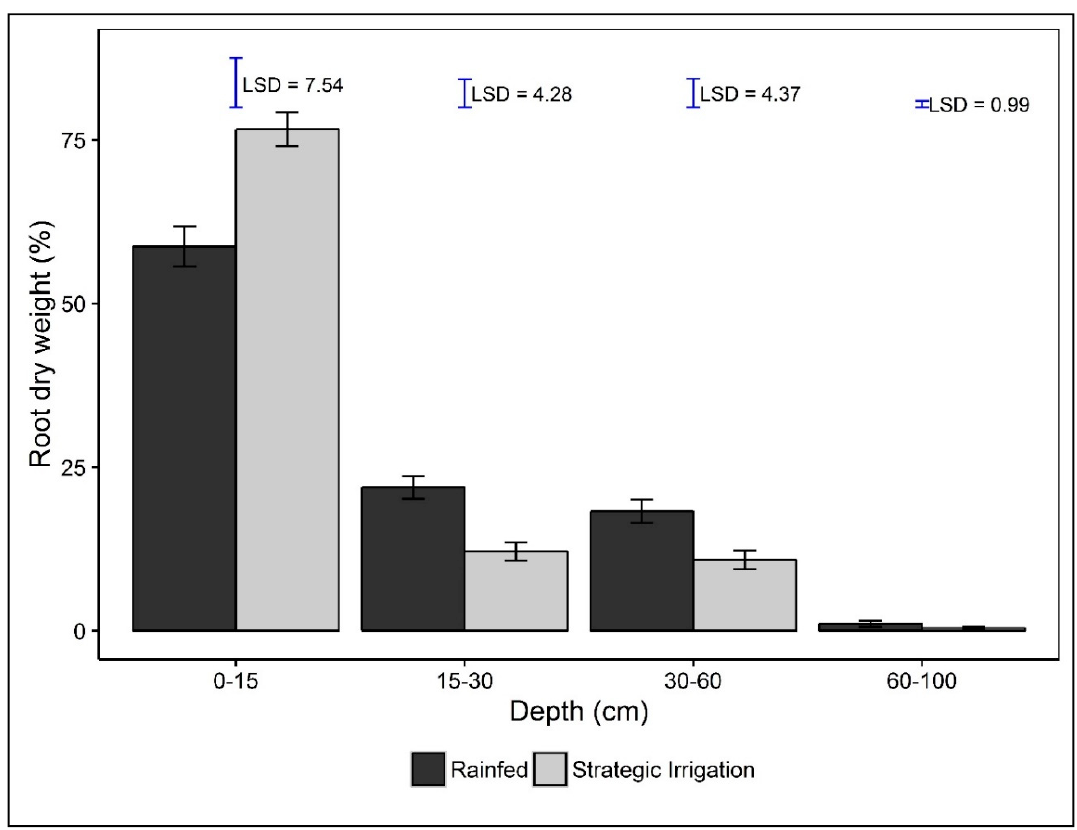
Figure 3. Root dry weight distribution (%) at different depths under strategically irrigated and rainfed treatments, Alton Downs 2015. Least significant difference (LSD) within a depth at p = 0.05.